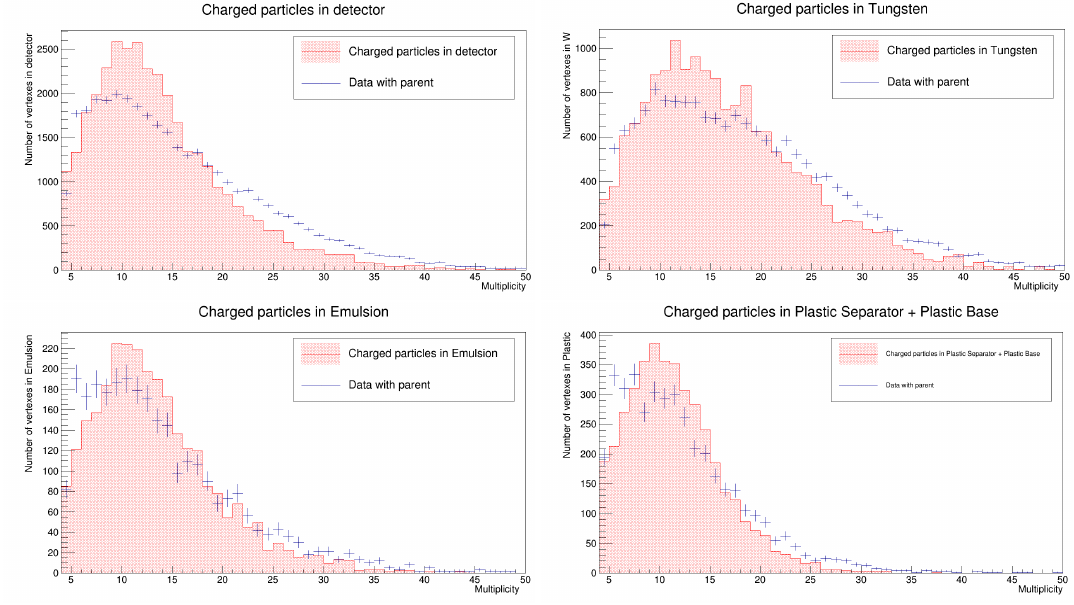
Figure 4. MC cross-checks for multiplicity distributions in each material from the detector structure.